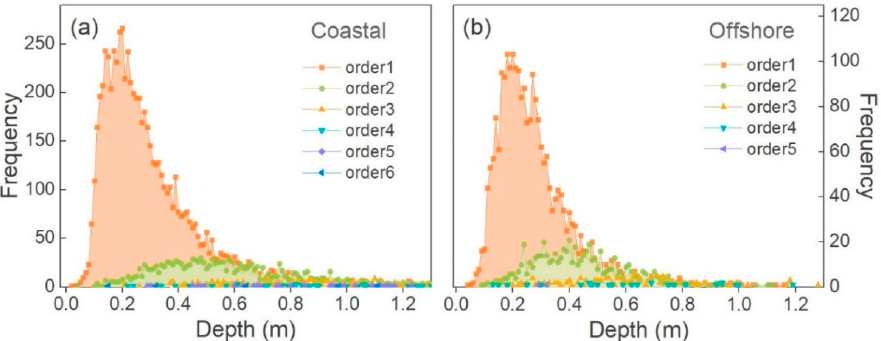
Figure 8. Frequency of the depth of ( a ) coastal and ( b ) offshore tidal creeks of different order.